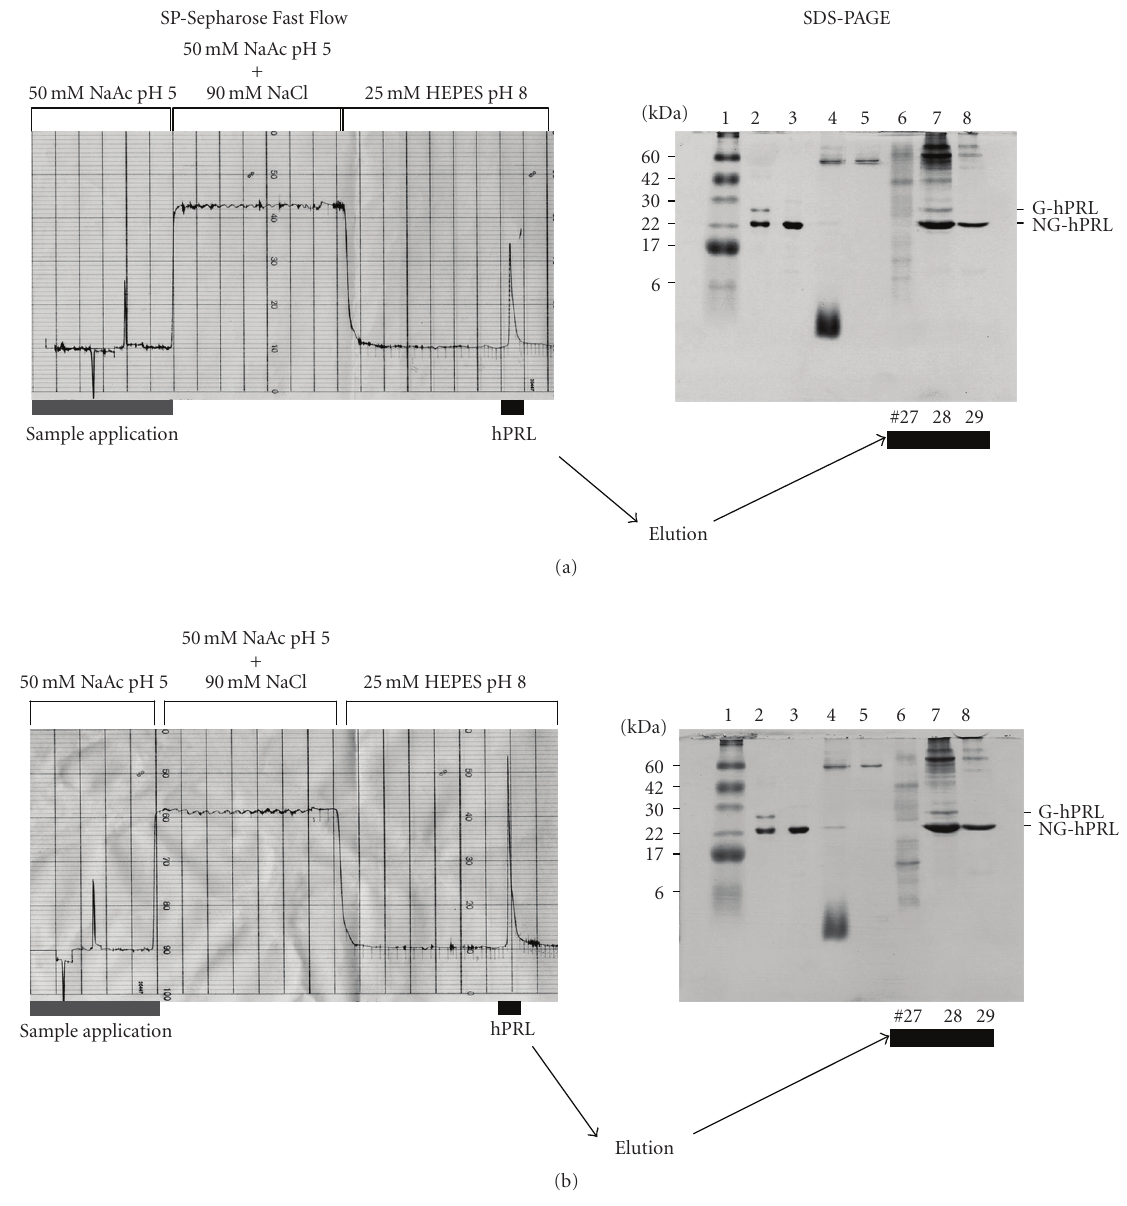
Figure 6: Example of chromatographic purification of hPRL on SP-Sepharose Fast Flow and SDS-PAGE analysis of CHO cell-conditioned medium of (a) nontreated cells and (b) cells treated with 1mM NaBu. Lane 1: molecular mass marker. Lane 2: Chemical Reference Standard of G-hPRL and NG-hPRL (WHO-CRS). Lane 3: Internal Reference of periplasmic E. coli- derived hPRL. Lane 4: CHO-conditioned medium. Lane 5: unretained fraction. Lanes 6–8: fractions eluted with 25mM HEPES, pH 8.0. NaAc: sodium acetate.